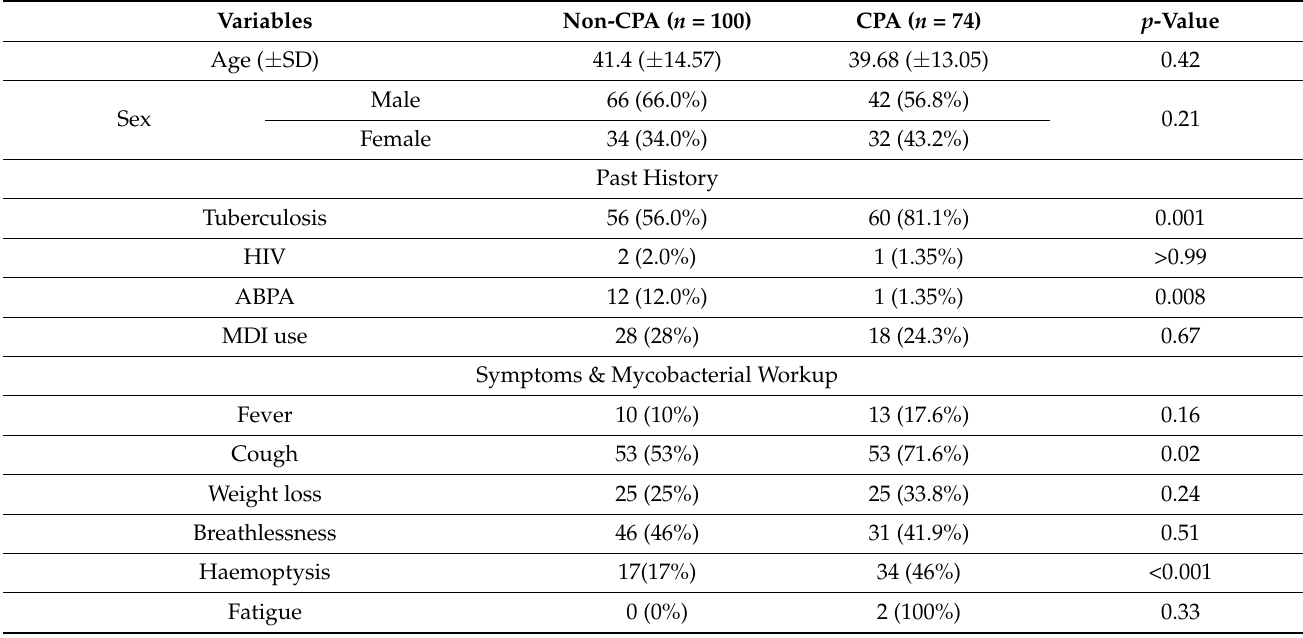
Figure 1. Enrolment in the study. Table 1. Comparison of baseline demographics.